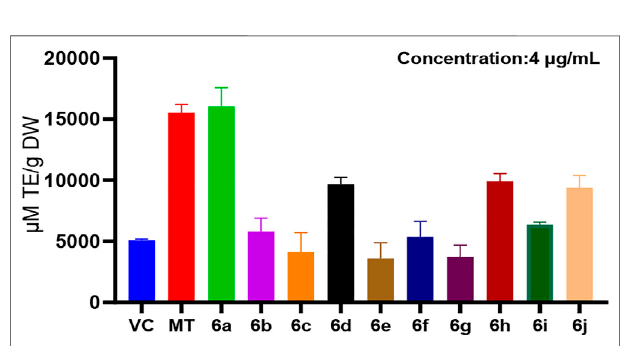
FIGURE 2 | ORAC method for measuring the antioxidant activity of 6a~